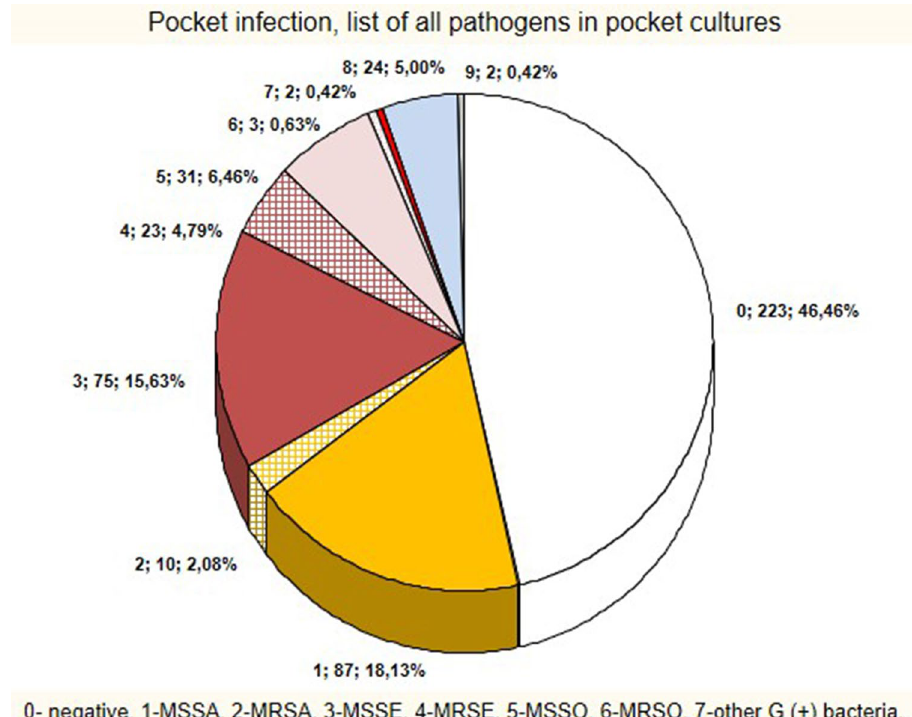
Figure 2. PI subgroup—list of